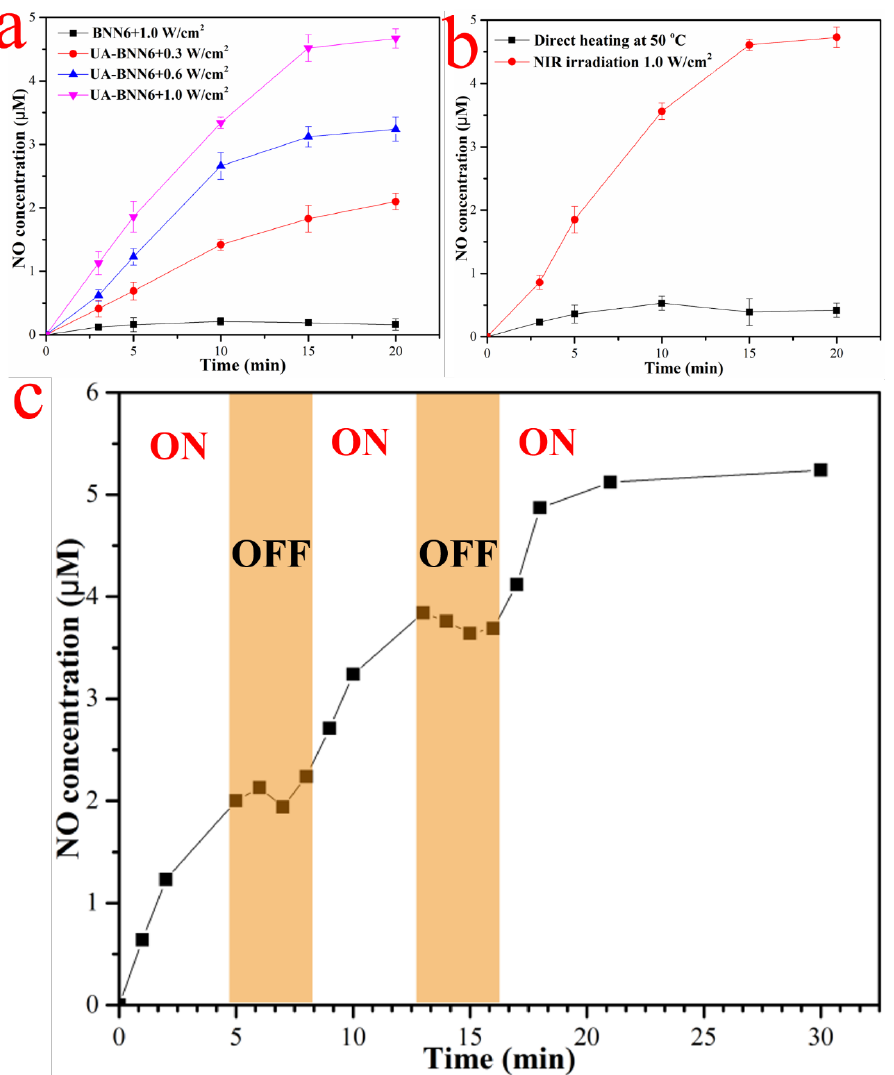
Figure 4. ( a ) The NO release curves of UA-BNN6 under various 808 nm NIR laser power densities. ( b ) The effects of direct heating and 808 nm NIR laser irradiation on NO release from UA-BNN6. ( c ) The on/off generation of NO upon NIR laser irradiation (808 nm, 1.0 W cm −2 ). The biocompatibility of UA was evaluated using the MTT assay. The results (Figure 5a) show that even if UA concentration reaches 50 μg /mL, the cell survival rate of HeLa cells is still as high as 87.7%, indicating that our nanomaterial has low cytotoxicity. Subsequently, UA – FITC obtained by replacing BNN6 molecules with FITC molecules was co-incubated with HeLa cells, and the nuclei were labeled with Hoechst 33342 dye. Fi- nally, a laser scanning confocal microscope (LSCM) was used to observe the uptake or our nanomaterial by HeLa cells with a 60× oil-immersion objective. As displayed in Figure 5b, strong green fluorescence appears in the cytoplasm, while only blue fluorescence appears